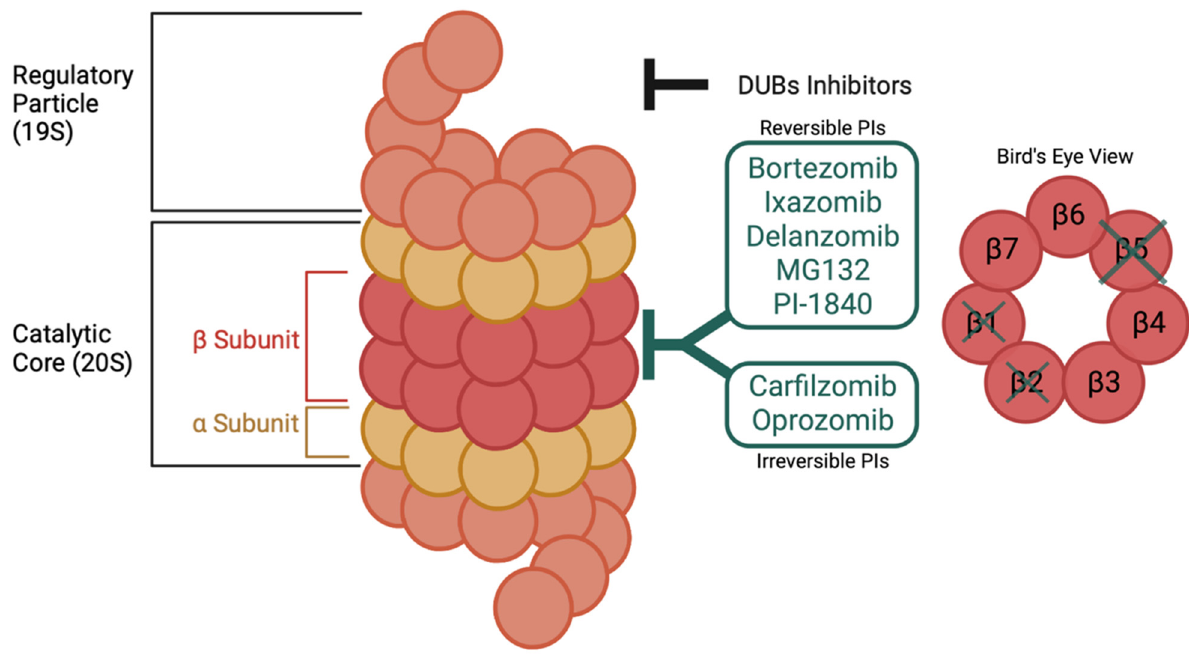
Figure 1. Overview of proteasome structure and target sites of inhibitors. The proteasome’s multiprotein complex is composed of a catalytic core and regulatory particles. The majority of clinically used compounds preferentially target the β 5 site of the 20S catalytic core (e.g., Reversible PIs, Irreversible PIs). However, compounds directed towards the 19S regulatory subunit of the proteasome, generally targeting deubiquitinases (DUBs), are currently under investigation. Since they bind to an alternative site on the proteasome, they would be particularly useful in overcoming resistance to compound targeting the 20S core.